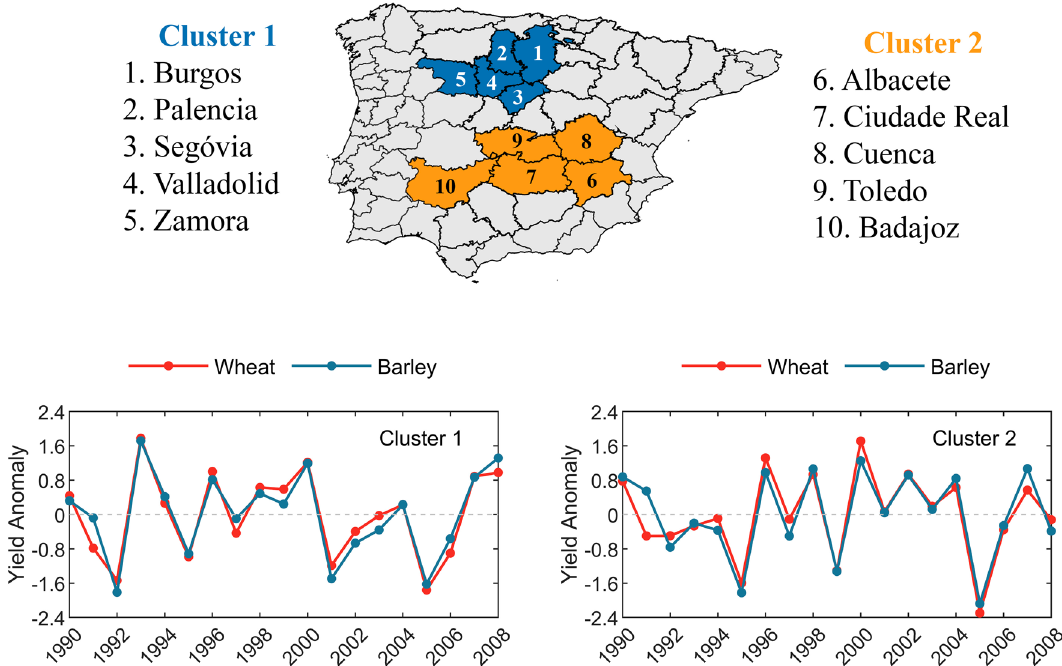
Figure 1. (top) Map with provinces that encompass cluster 1 (blue) and cluster 2 (orange); (bottom) Standardized detrended yield anomaly (μ = 0, σ = 1) of wheat (red) and barley (blue) for cluster 1 (left panel) and cluster 2 (right